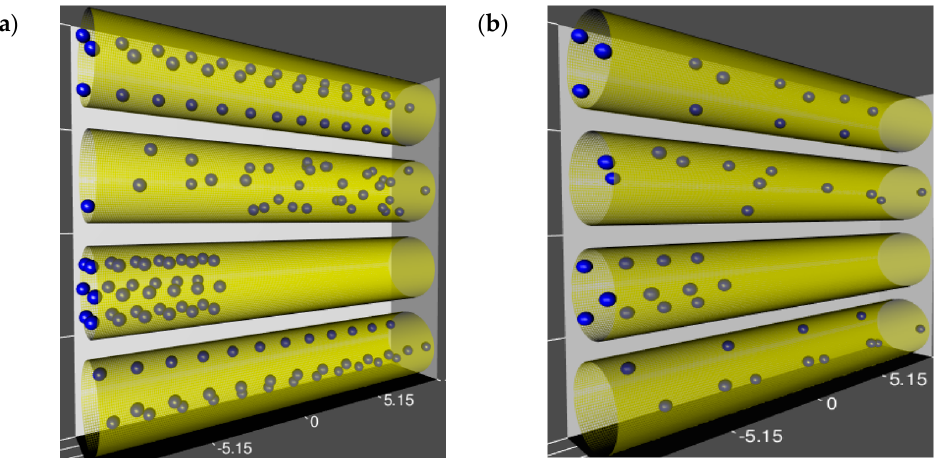
Figure 3. Simulated cell wall pores with blues spheres showing the position of energy pits with spatial distributions from the top to the bottom: even, random, clustered, helix. ( a ) PW 1 pores; ( b ) PW 2 pores. Table 2. Summary of energy pit settings on simulated cylindrical pore walls .